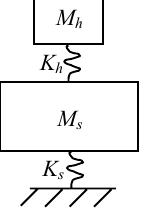
Fig. 2. The approximate TDOF model of a spring-mass-beam